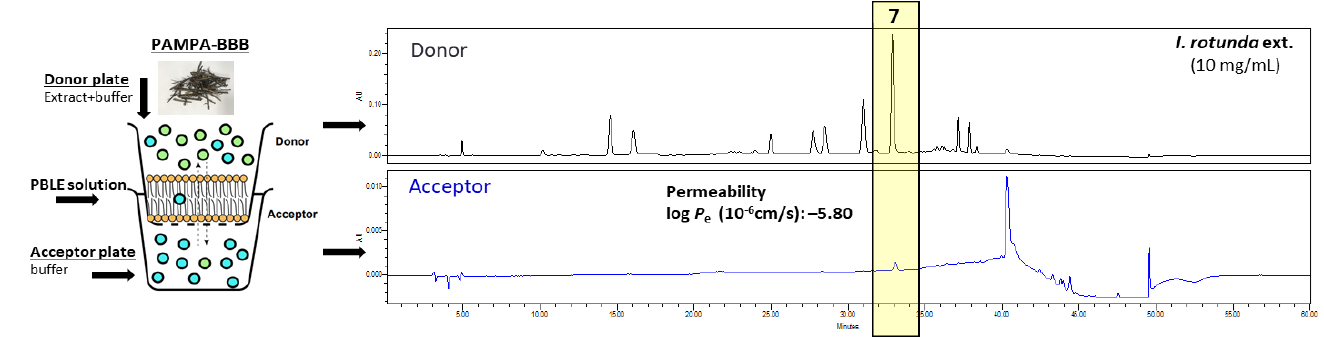
Figure 6. Result of the PAMPA-BBB experiment of the extract of I. rotunda twigs. Compound 7 detected in donor and acceptor wells.